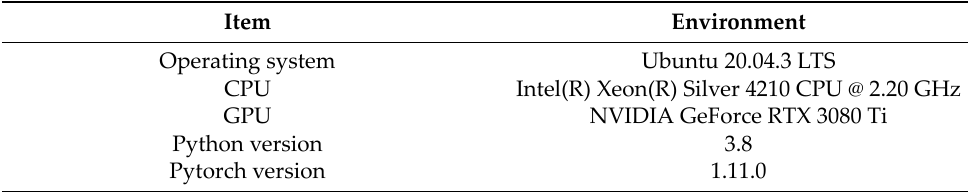
Table 3. Experimental environment